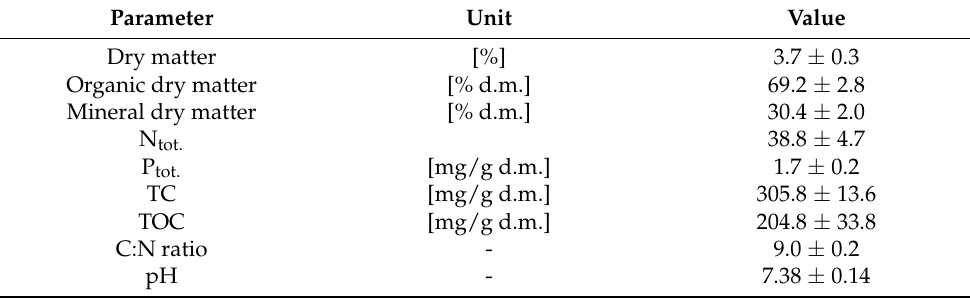
Table 3. Characteristics of anaerobic sludge (AS) used in experiments.